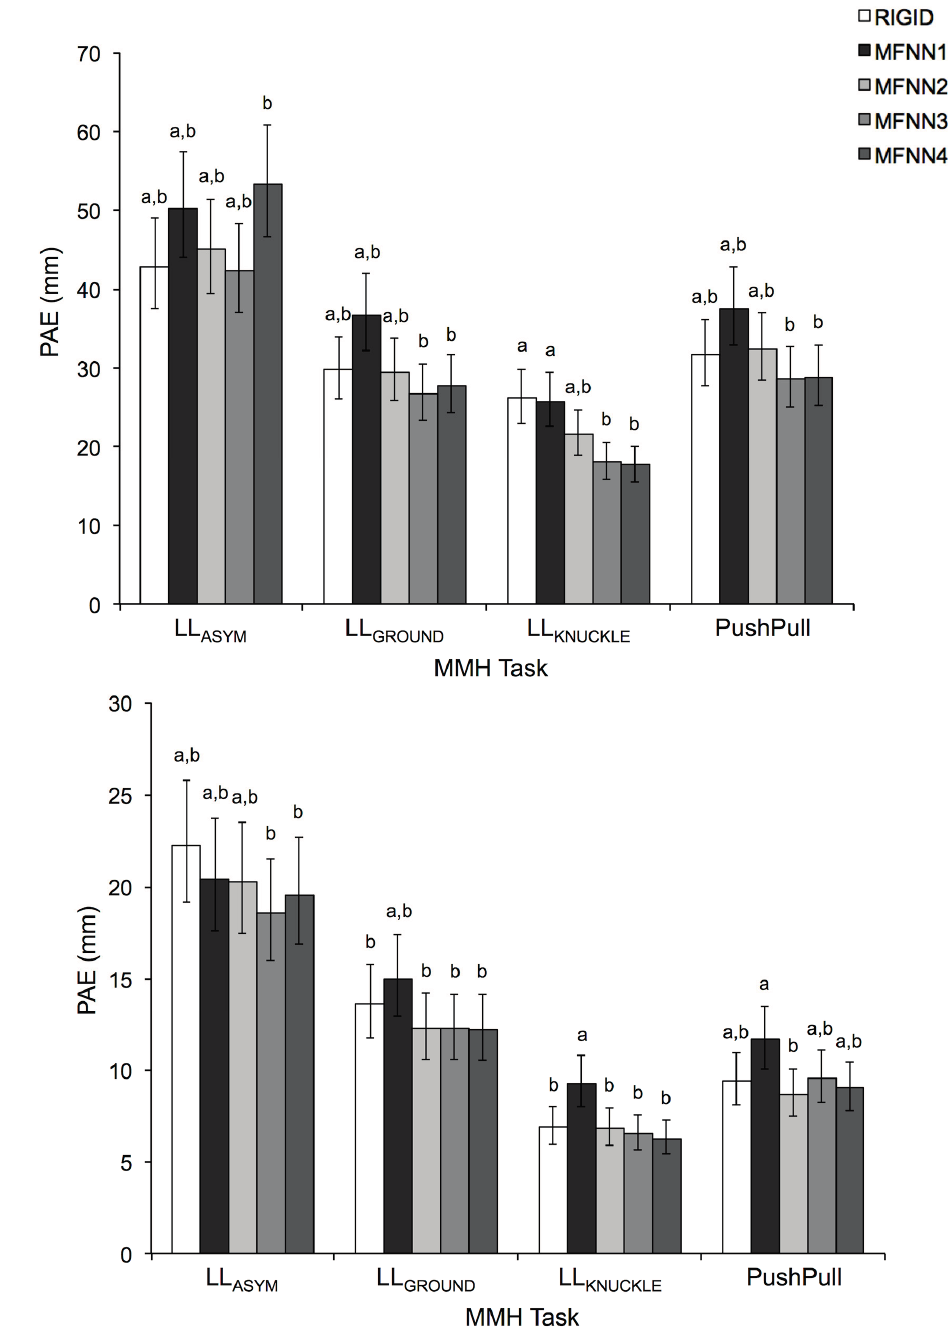
Figure 3. Peak absolute errors (PAE) in the AP ( Top ) and the ML ( Bottom ) directions for each MMH task type, with respect to the different methods for (cid:1794) (cid:2893)(cid:2924)(cid:2929)(cid:2925)(cid:2922)(cid:2915)(cid:2903)(cid:2918)(cid:2925)(cid:2915) . Pairs of values with different letters are significantly different within a given MMH task type, and error bars indicate 95% confidence